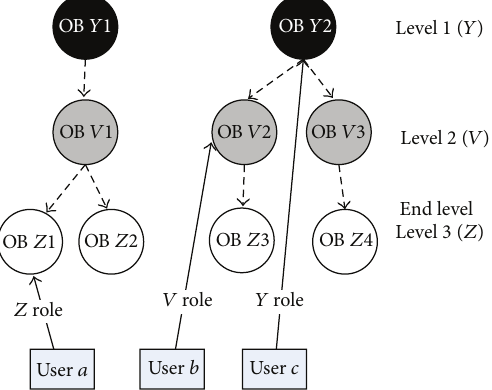
Figure 7: Relations between users and objects in the hierarchical presocial network